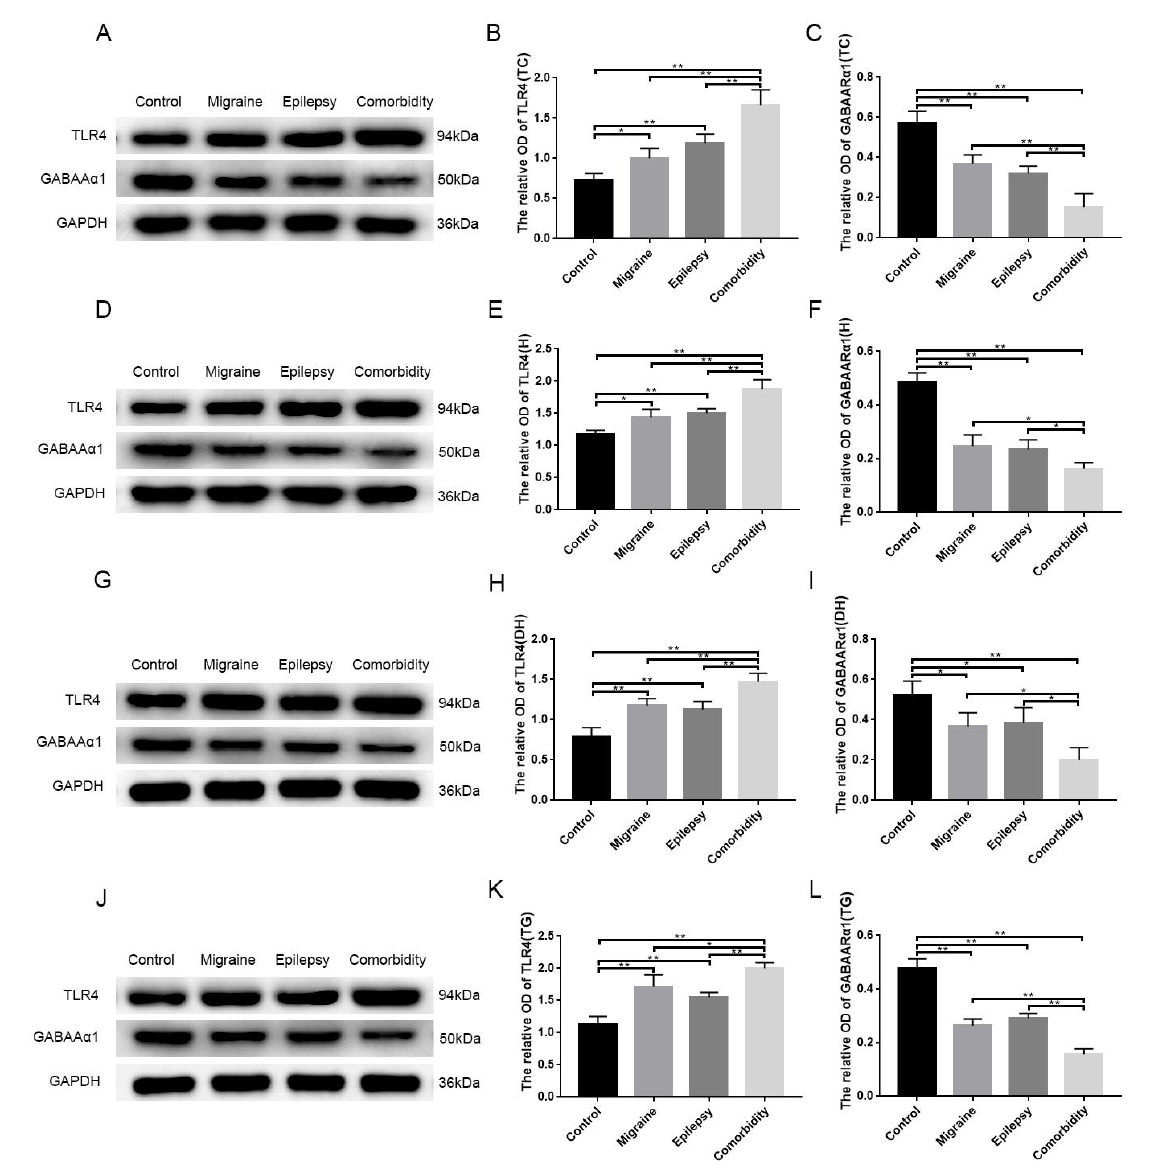
Figure 2. The disrupted expression of TLR4 and GABAAR α 1 in different brain sites. Protein extracts were immunoblotted with antibodies to TLR4, GABAAR α 1, and GAPDH. The blots were stripped between antibodies and results expressed as densitometric units ± SEM. Expression levels of TLR4 and GABAAR α 1 protein in the temporal cortex ( A – C ), hippocampus ( D – F ), medullary dorsal horn ( G – I ), and trigeminal ganglion ( J – L ) were determined using western blotting and quantitative assessment. Significant differences were observed between the epilepsy–migraine comorbidity group and the other three groups ( n = 3, * p < 0.05, ** p < 0.01). There were no apparent differences between the migraine group and the epilepsy group. TC: temporal cortex, H: hippocampus, DH: medullary dorsal horn, TG: trigeminal